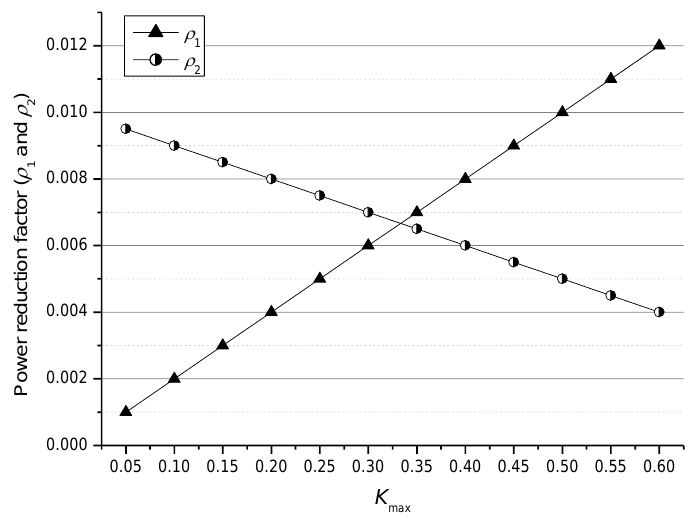
Figure 3. Curves of power reduction factors associated with Figure 2.